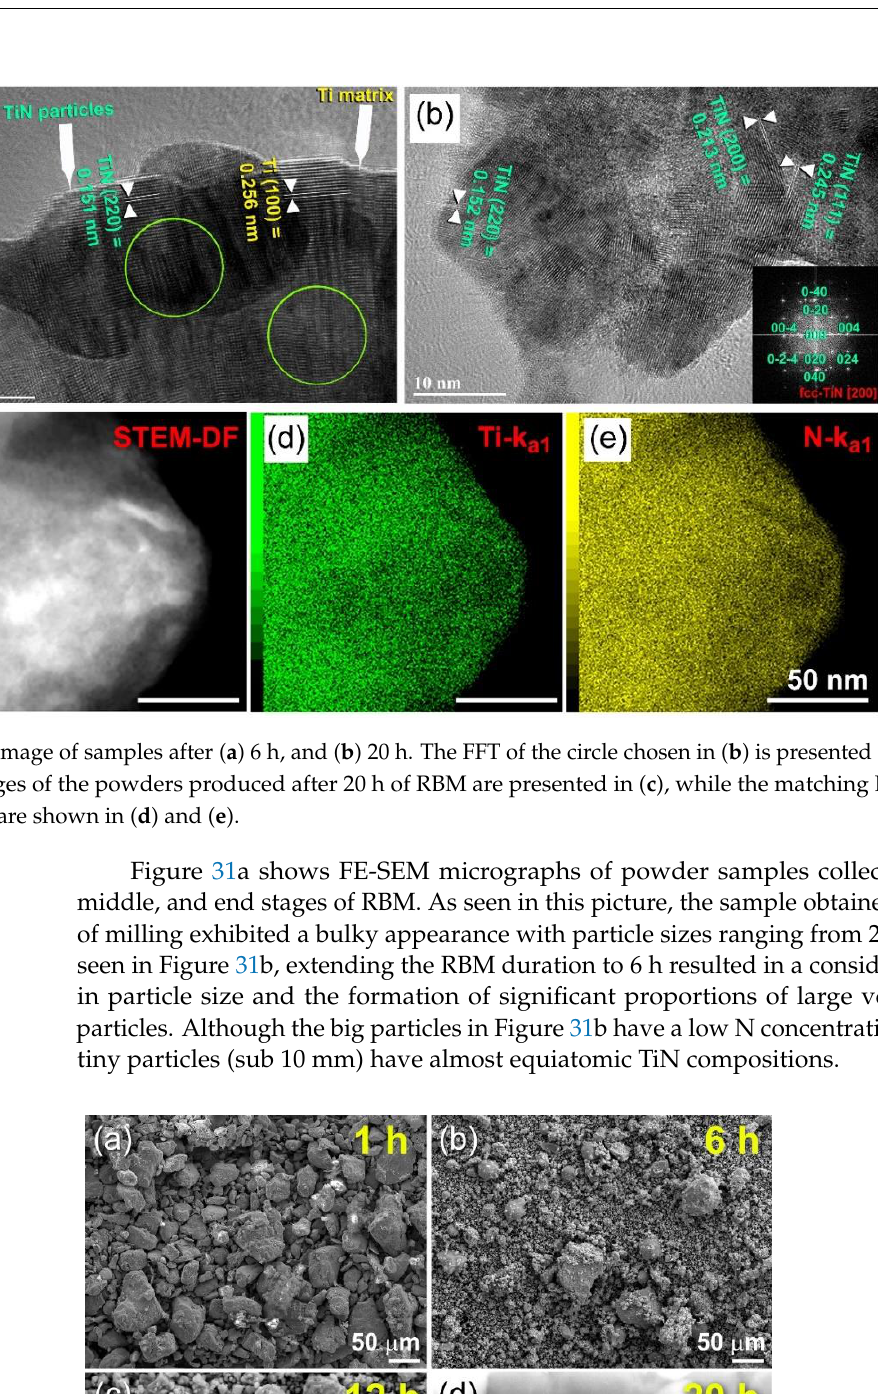
Figure 31. FE-SEM micrograph of the powder samples obtained after ( a ) 1 h, ( b ) 6 h, ( c ) 12 h, and ( d ) 20 h of RBM.